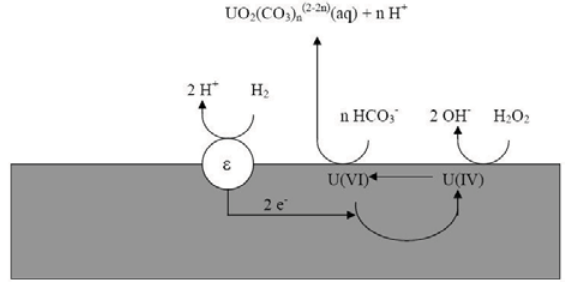
Figure 2. Elementary processes involved in radiation induced oxidative dissolution of spent nuclear fuel.